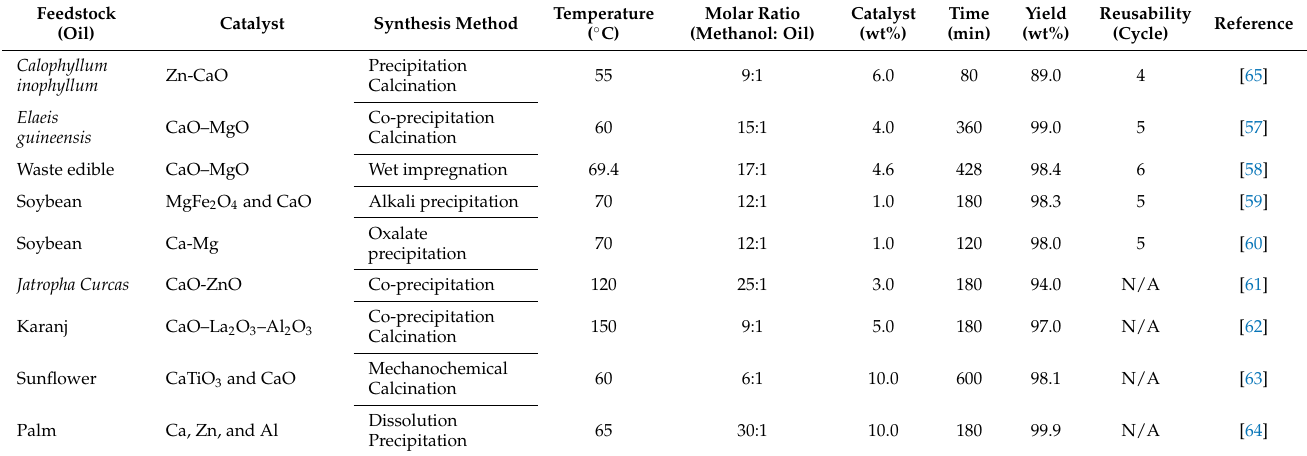
Table 3. Mixed oxide CaO catalyst and reaction conditions in biodiesel